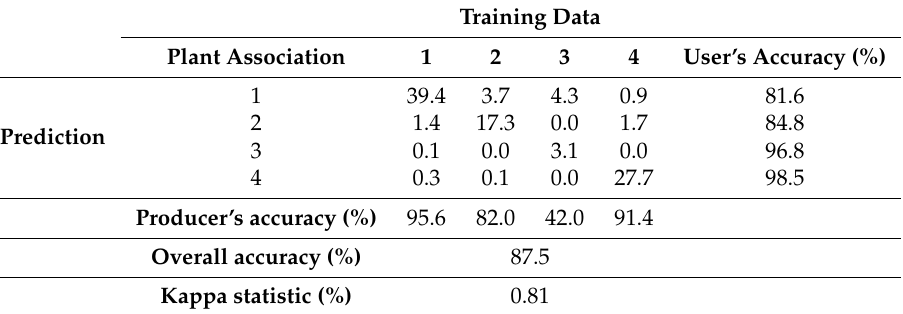
Figure 6. Forest plant associations and habitat map of Mount Conero (Central Italy) obtained by the supervised random forest classification of the main seasonal remotely sensed (NDVI) phenological variations, and the main topographic and lithological gradients. Legend (Plant associations): 1- Cephalanthero longifoliae-Quercetum ilicis ; 2- Cyclamino hederifolii-Quercetum ilicis ; 3- Asparago acutifolii-Ostryteum carpinifoliae ; 4- Pinus halepensis and P. pinea plantation. Cephalanthero longifoliae-Quercetum ilicis and Cyclamino hederifolii-Quercetum ilicis belong to habitat 9340 listed in Annex I of the Habitats Directive. Table 3. Cross-validated confusion matrix (10-fold, repeated 20 times) between the predicted forest plant association of the Mount Conero (Central Italy). Entries are the percentage of the average counts across repeats. Producer’s accuracy and user’s accuracy (in percentage) for plant associations are given. Plant association: 1- Cephalanthero longifoliae-Quercetum ilicis ; 2- Cyclamino hederifolii-Quercetum ilicis ; 3- Asparago acutifolii-Ostryteum carpinifoliae ; 4- Pinus halepensis and P. pinea